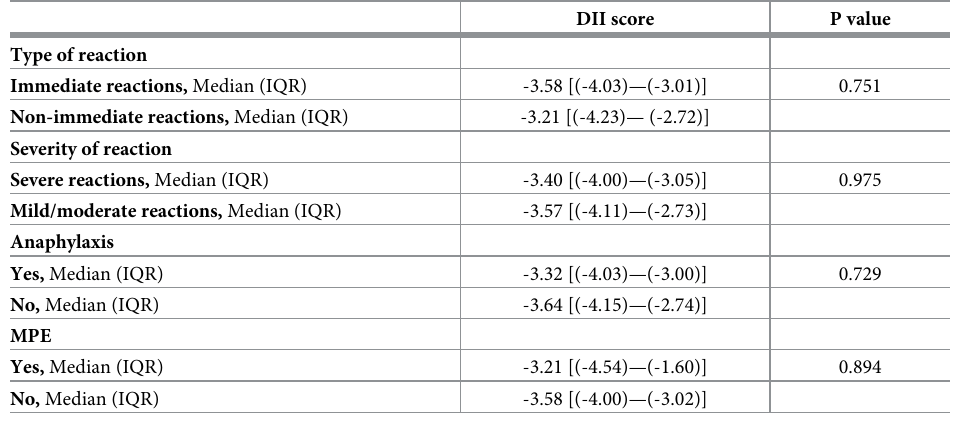
Table 1. Patients with drug allergy: DII scores and characteristics of the reaction.